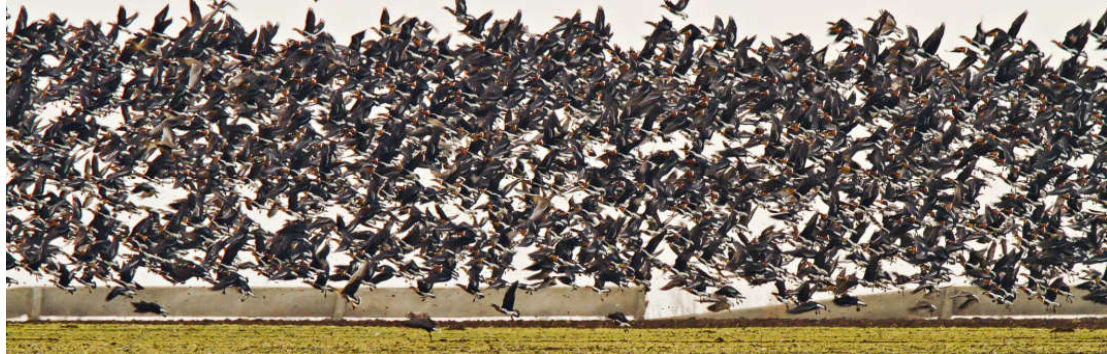
Europe [52] by the extension and presence of the high atmospheric pressure over the Figure 3. Agglomeration of birds (red-breasted goose) which roost in Nuntași–Tuzla lakes. Figure 3. Agglomeration of birds (red-breasted goose) which roost in Nuntas Azores Islands which extended over the Mediterranean basin [53]. Waders use the area mainly for feeding, so their number depends on both the WS and the depth and/or the extent of the mudflats.